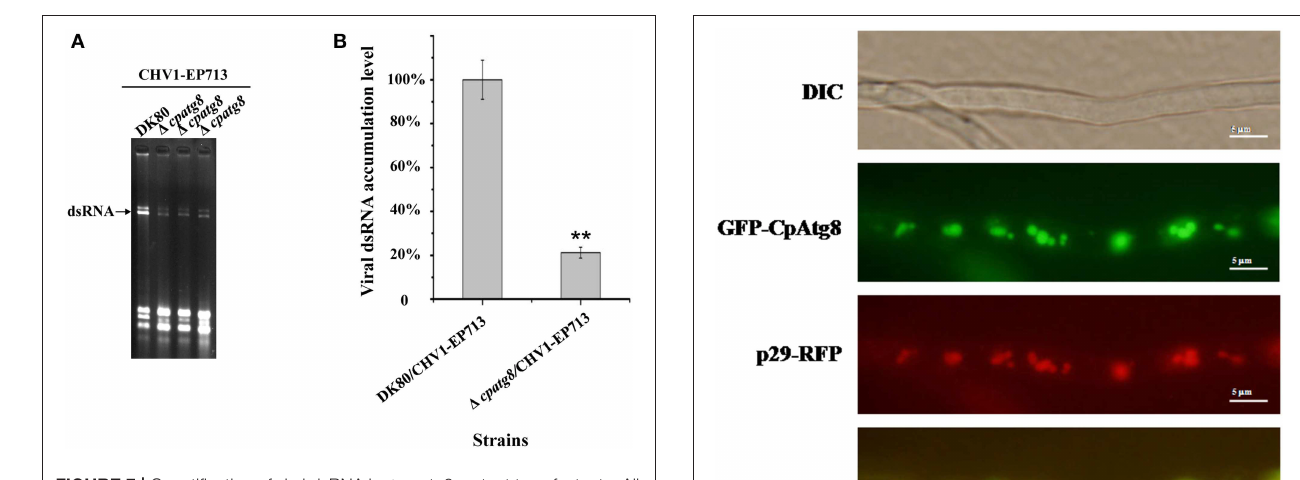
FIGURE 7 | Quantification of viral dsRNA in 1 cpatg8 mutant transfectants. All transfectants were in the DK80 genetic background. (A) Agarose gel electrophoretic analysis of viral dsRNA. Ten micrograms of total RNA from virus-infected hosts was loaded into each lane in a 1.0% agarose gel. Lane 1, DK80/CHV1-EP713; lane 2 to lane 4, 1 cpatg8 mutant transfectants with CHV1-EP713. The arrow indicates the position of viral dsRNA. (B) Semi-quantification of viral dsRNA from different transfectants. The viral dsRNA level of EP155/CHV1-EP713 was set at 100%, and levels of 1 cpatg8 mutant transfectants were expressed as percentages of that of CHV1-EP713. Values are means ± S.E.M of three independent experiments. ** indicates P < 0.01, determined by Student’s t -test.